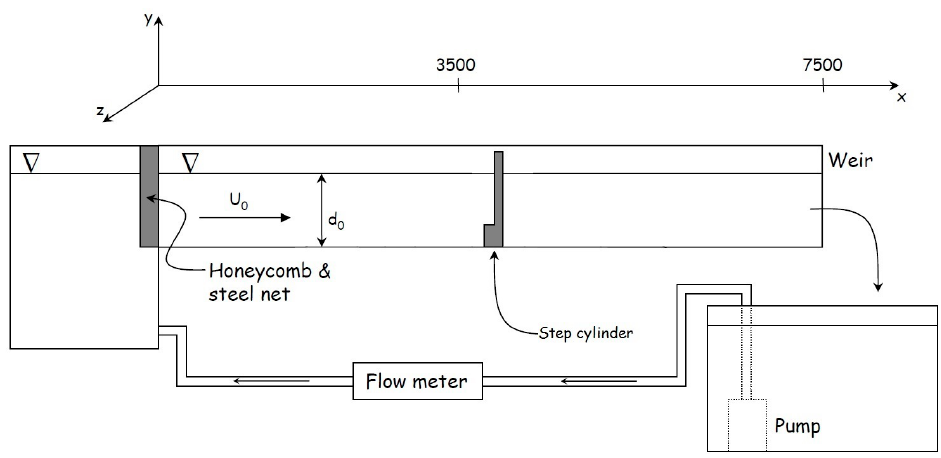
Figure 2. Schematic presentation of water circulation in the flume.